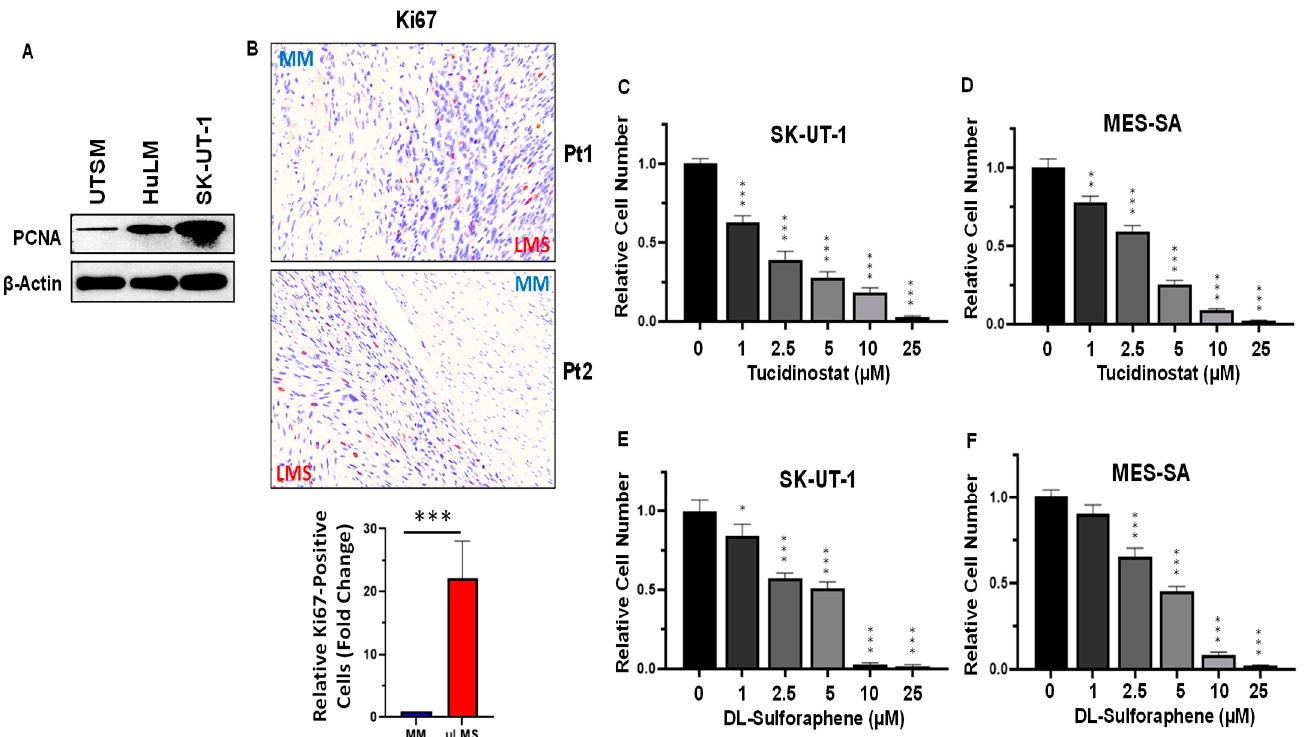
Figure 5. Treatment with Tucidinostat and DL-sulforaphane decreases uLMS cell proliferation . ( A ): Abnormal cell proliferation in uLMS cells validated by Western blot using anti-PCNA antibody; ( B ): IHC staining revealed the increased Ki67-positive cells in uLMS tissues compared to the myometrium. Lower panel is the quantitative analysis of Ki67-positive cells between uLMS and adjacent myometrium ( n = 3) using QuPath software. ( C ): Cell proliferation in SK-UT-1 cells in the presence or absence of Tucidinostat; ( D ): Cell proliferation in MES-SA cell line in the presence or absence of Tucidinostat; ( E ): Cell proliferation in SK-UT-1 cell line in the presence or absence of DL-Sulforaphane; ( F ): Cell proliferation in MES-SA cell line in the presence or absence of DL-Sulforaphane.* p<.0.05; ** p<.0.01; *** p < 0.001.